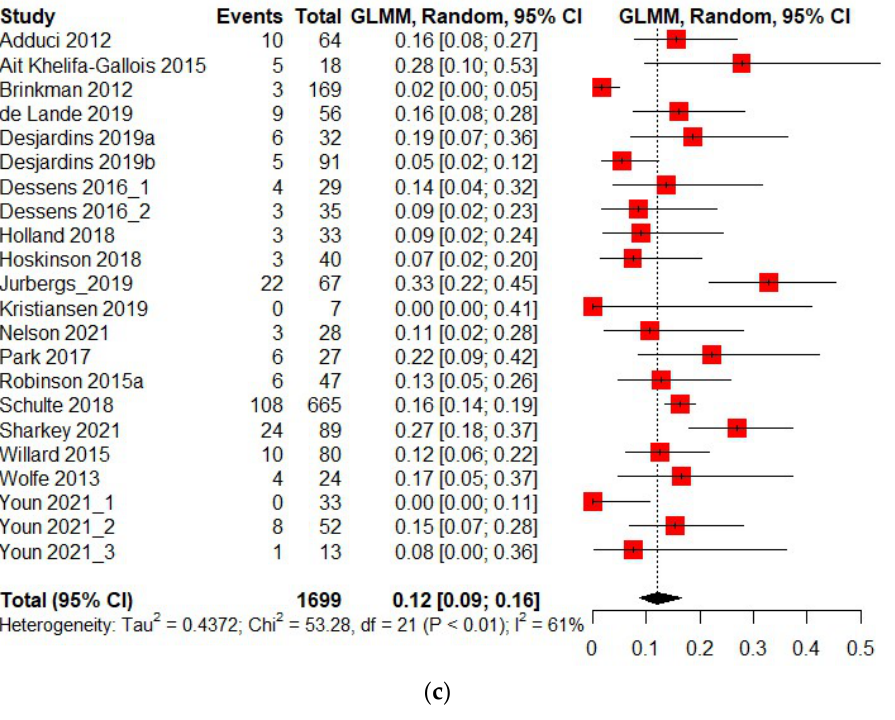
Figure 2. ( a – c ) Absolute risk of pediatric brain tumor survivors having neurobehavioral impairment. Dessens et al. (2016) [49] and Youn et al. (2021) [83] reported more than one independent cohort in their study [24,30,36,37,39,40,42,43,45–47,49,55–58,60,61,63–66,70–75,77,81–83]. ( a ) Abso-lute risk—attention problems; ( b ) Absolute risk—emotional; ( c ) Absolute risk—psychosocial problems